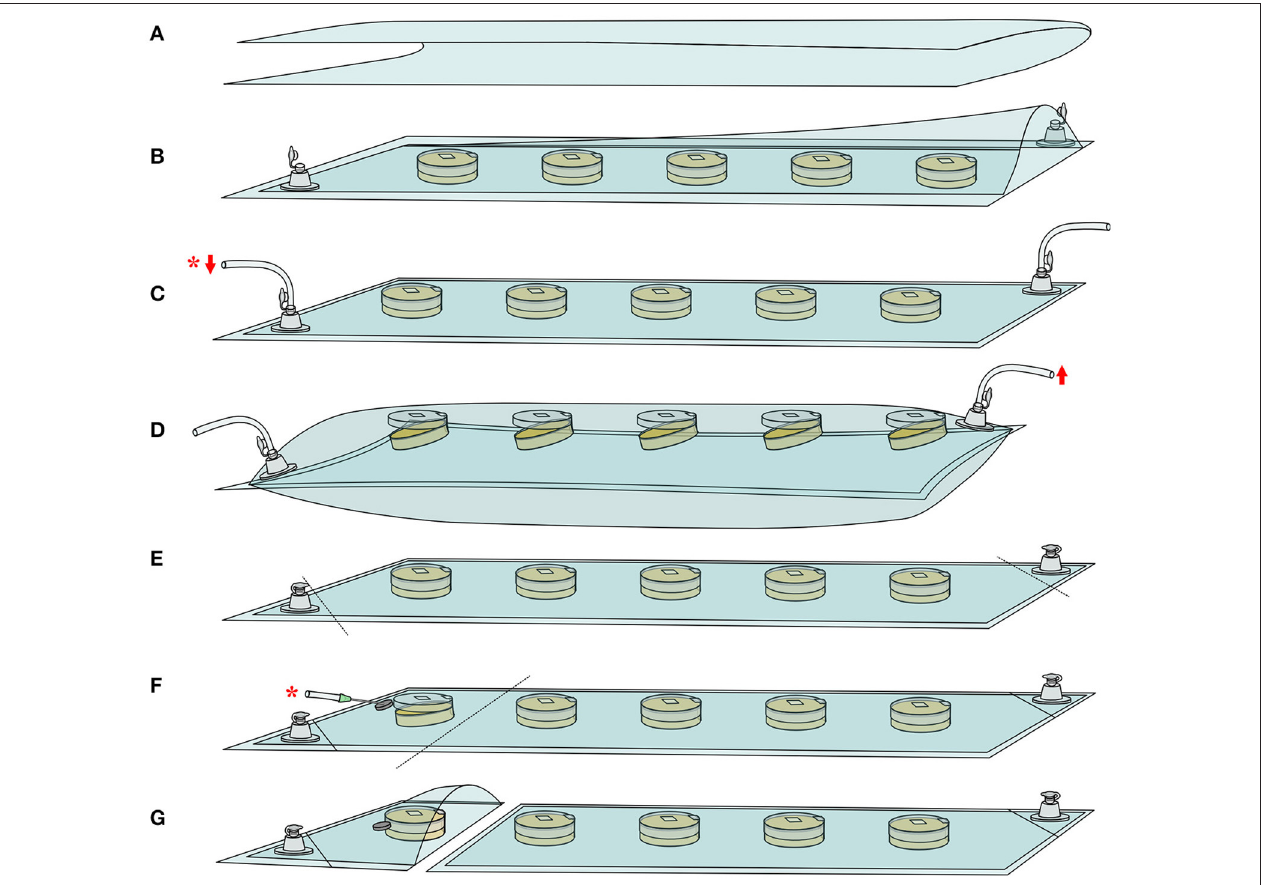
FIGURE 1 | Experimental device developed to monitor conidial germination on solid agar medium under modified atmosphere. See Material and Methods’ section for details. (A) Lengthwise folding of high oxygen barrier film. (B) Thermosealing, fixation of non-return PVC valves and placement of inoculated plates. Successive steps of (C) vacuum ( : ) and (D) filling ( : ) with the gas mixture. Vacuum steps are performed with a downstream gaseous composition measurement ( * ). (E) Isolation of the non-return valves by thermosealing prior to incubation. (F) Isolation of a dish and gaseous composition measurement ( * ). (G) Extraction of the isolated dish for germination